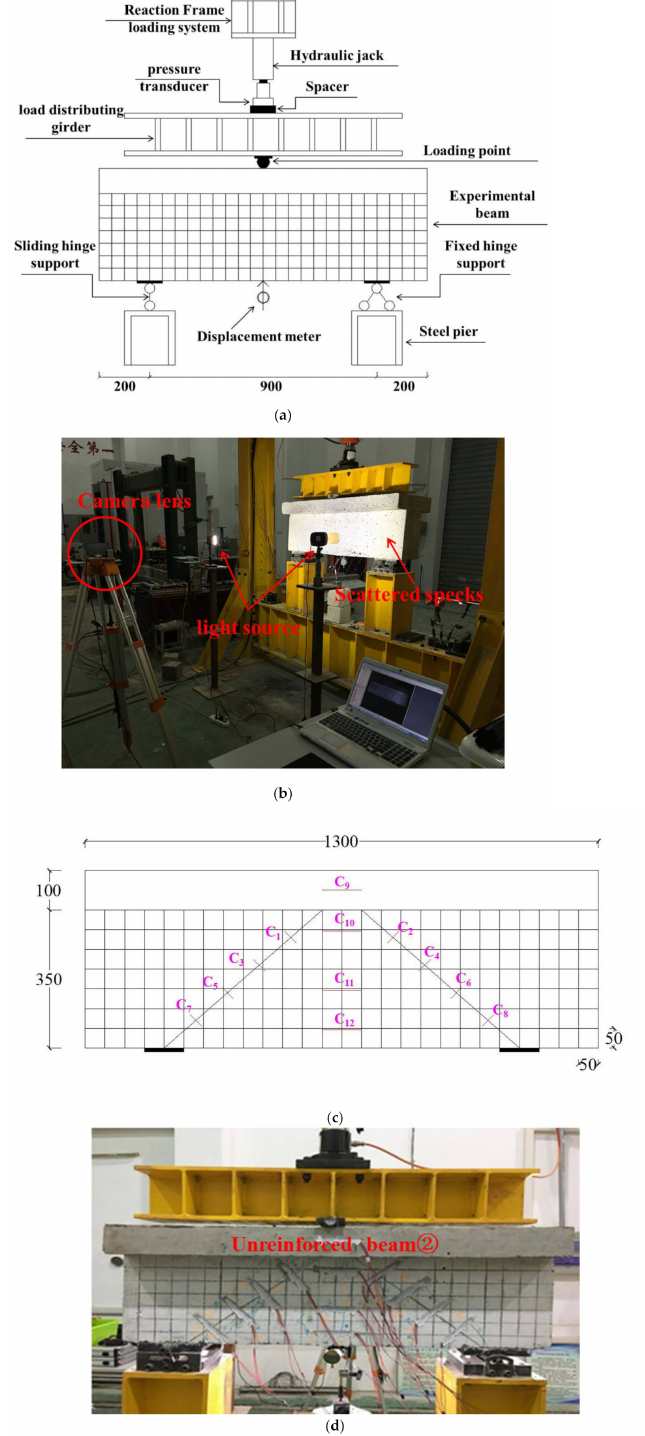
Figure 9. The setup of unreinforced deep T-beams under three-point bending loading: ( a ) Diagram of three-point beading test setup; ( b ) Diagram of three-point beading tests by DIC; ( c ) The location of strain gages in unreinforced beam. Note: strain gages C1-C12 are pasted on beam surface; ( d ) Unreinforced